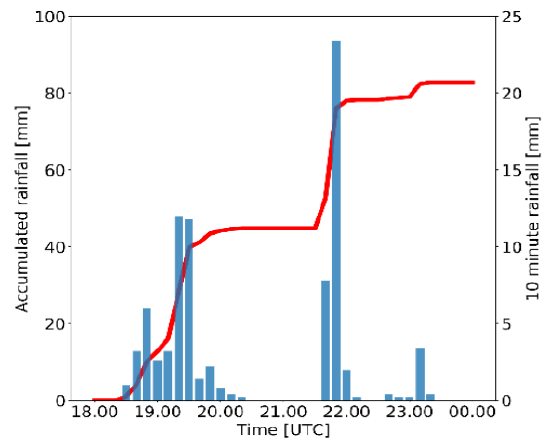
Figure 11. Histogram of the rainfall (blue bars) and accumulated rain (red line) at the Bergamo airport on 6 August 2019 airport on 6 August 2019 [46].